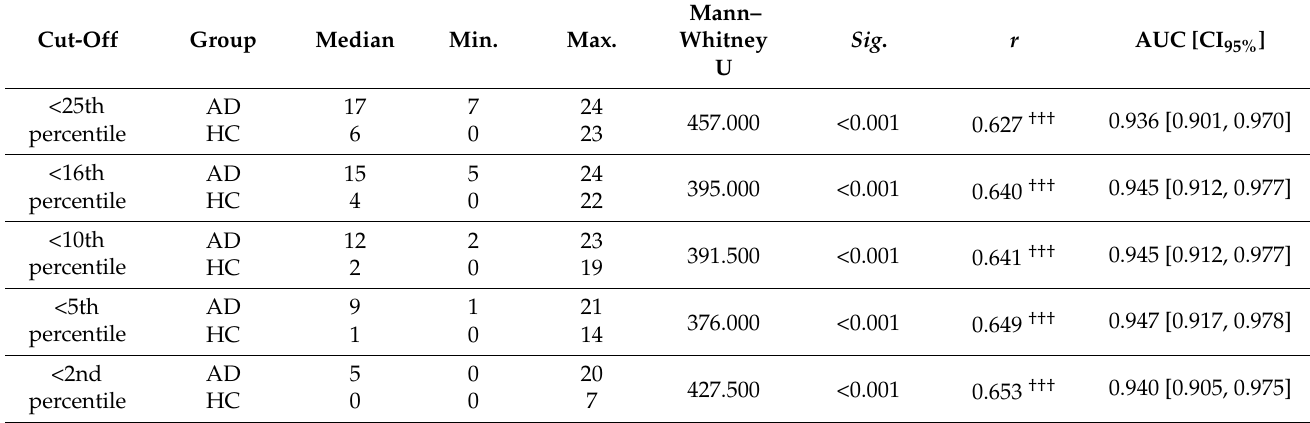
Table 3. Comparison between groups on the number of test scores falling below specified percentile cutoffs.